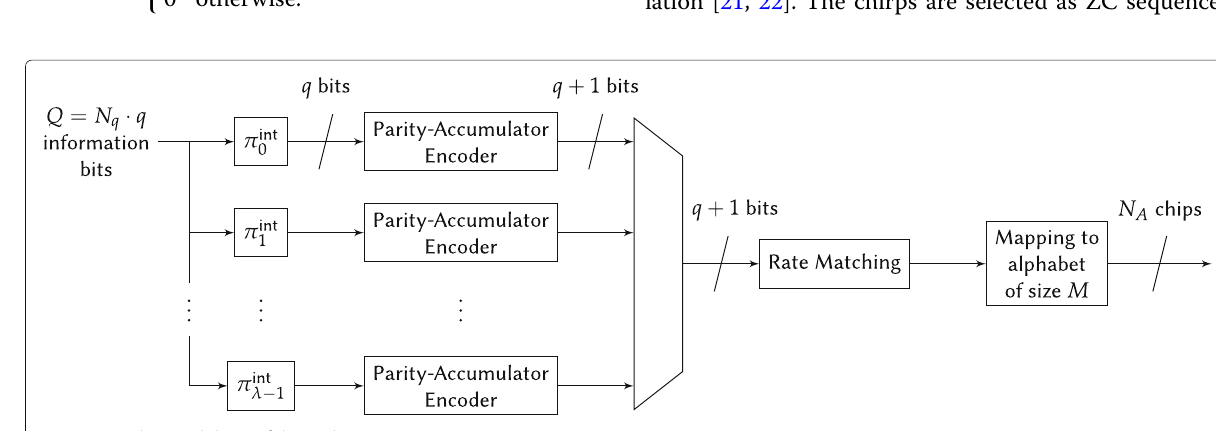
Fig. 2 Encoder/modulator of the Turbo-FSK